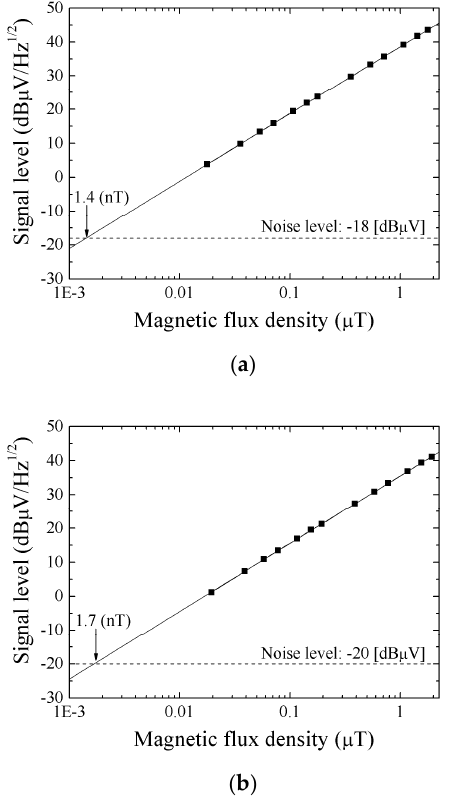
Figure 20. Results of evaluating sensitivity, ( a ) The surface normal field is zero, and ( b ) The surface normal field is 83.2 kA/m [21].